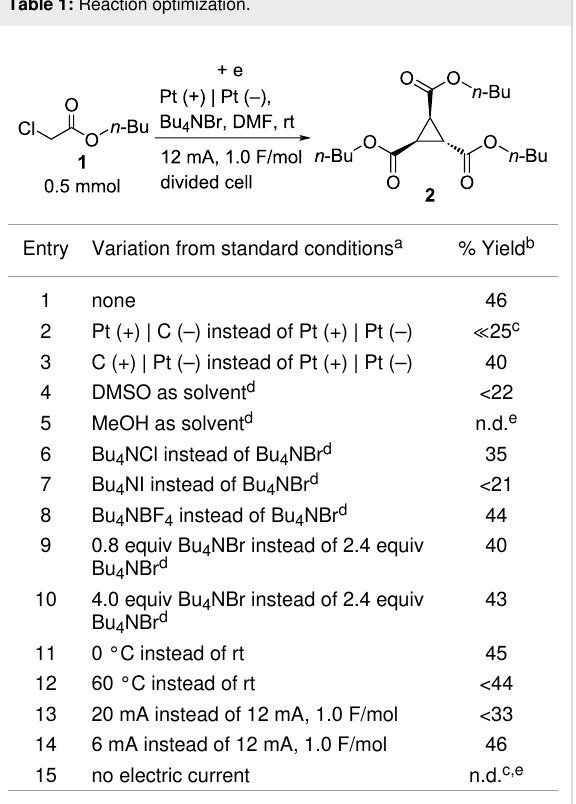
Table 1: Reaction optimization.